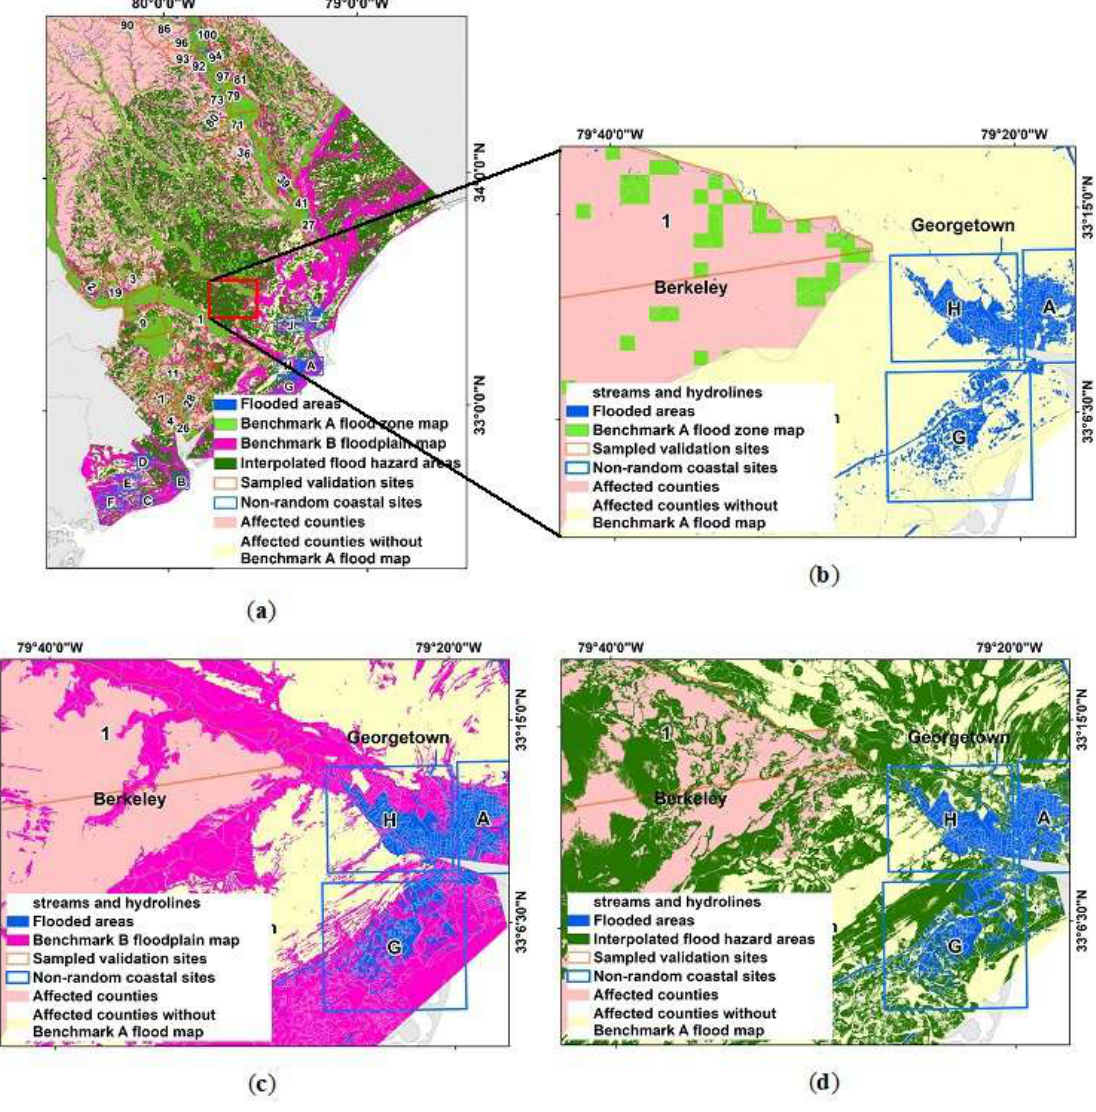
Figure 9. Spatial distribution of benchmarks and interpolated flood hazard areas: ( a ) shows an overlay comparison of benchmark floodplains and flood hazard areas vis- à -vis the di ff erent model predicted flood hazard areas, ( b ) shows an overlay comparison of benchmark A flood hazard zones vis- à -vis the actual flooded areas, ( c ) shows an overlay comparison of benchmark B floodplain map vis- à -vis the actual flooded areas, and ( d ) shows an overlay of the model predicted flood hazard areas vis- à -vis the actual flooded